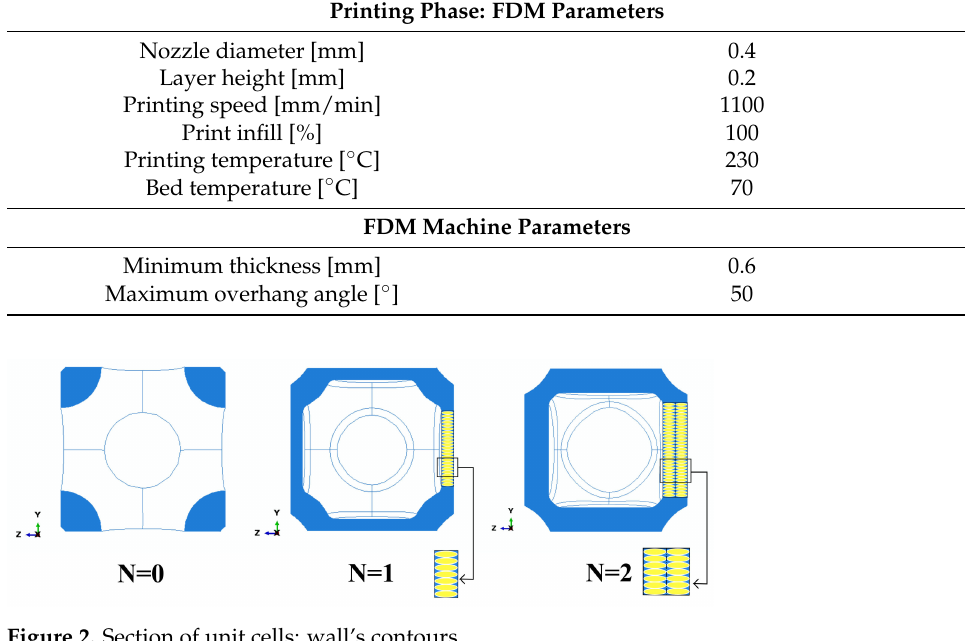
Figure 2. Section of unit cells: wall’s contours.